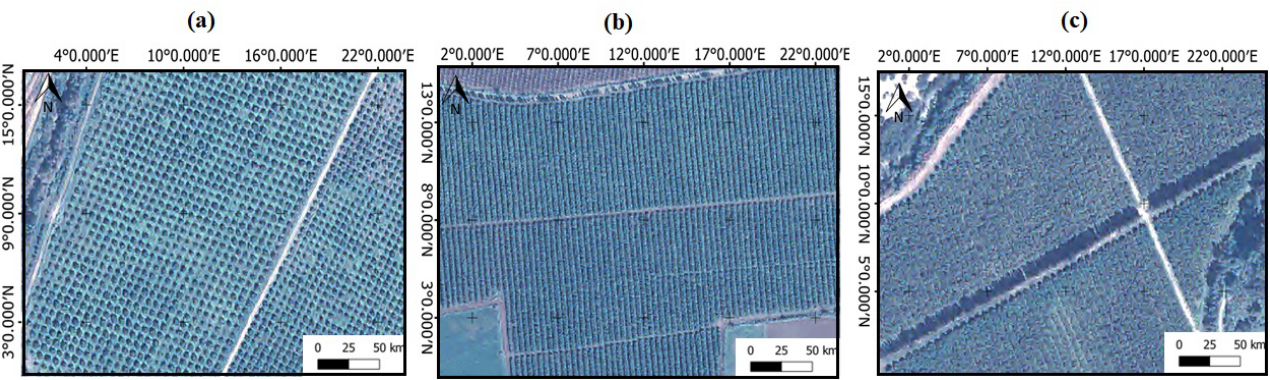
Figure 1. Different tree’s distribution in an orchard: ( a ) non-overlapping, ( b ) semi-overlapping, and ( c ) fully